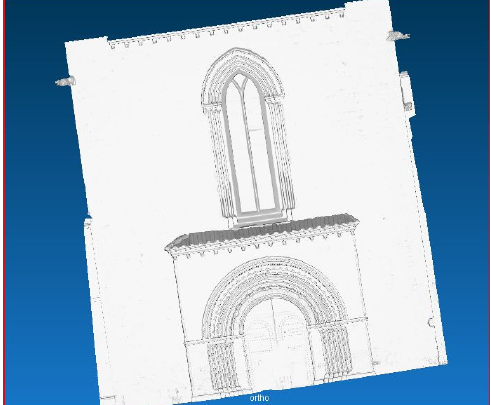
Figure 3: High resolution 3D model after the processing